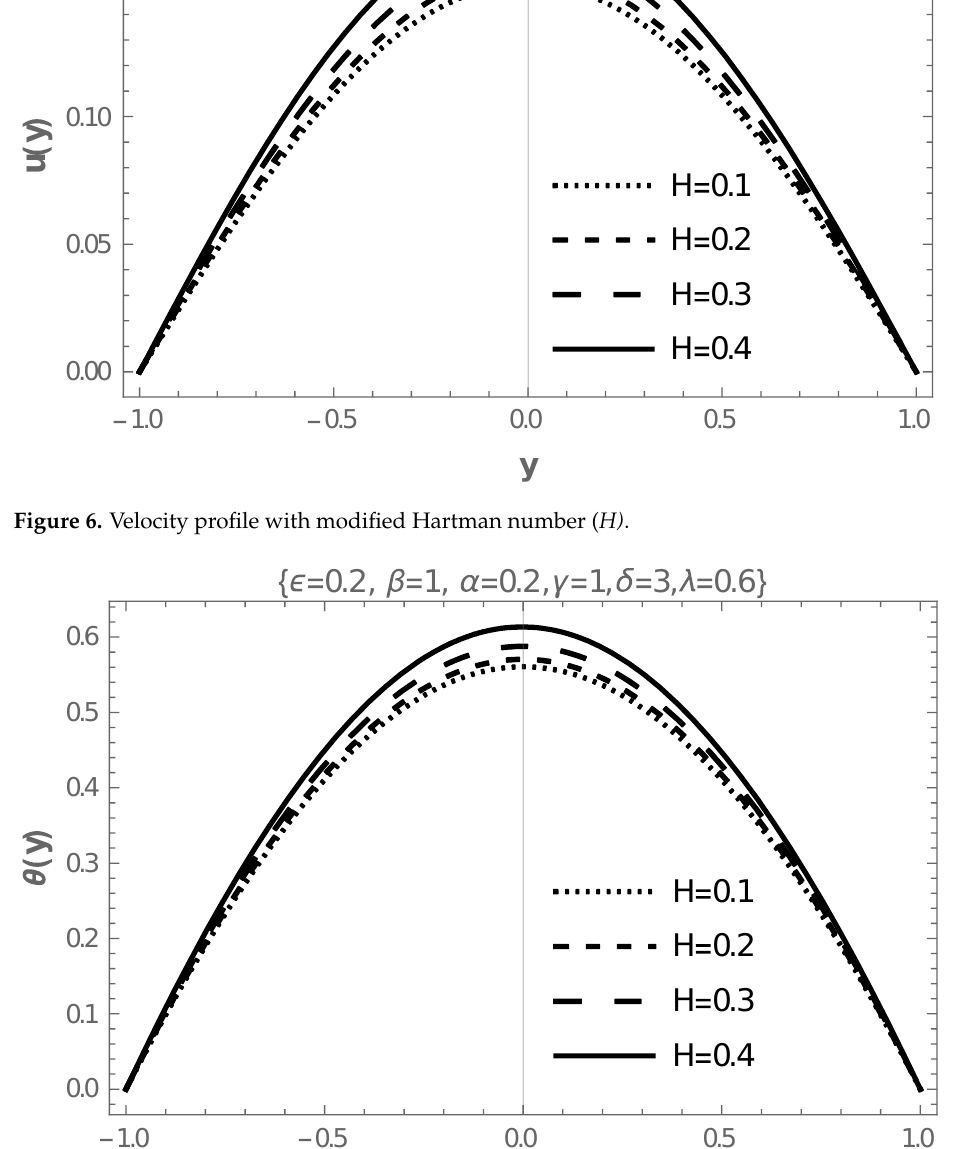
Figure 7. Temperature distribution with modified Hartman number ( H).